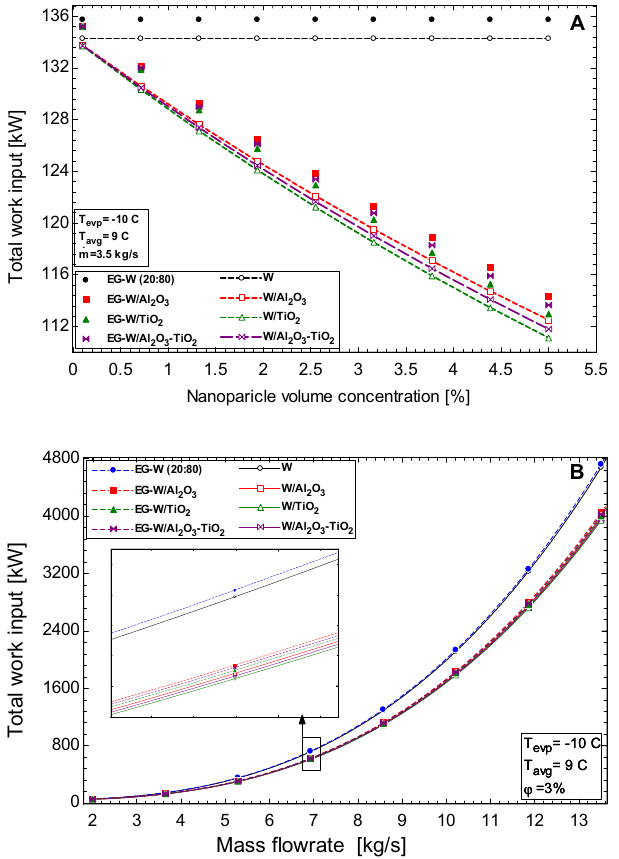
Figure 7. Effect of ( A ) nanoparticle volume concentration and ( B ) volume flowrate of working fluids on the work input of the